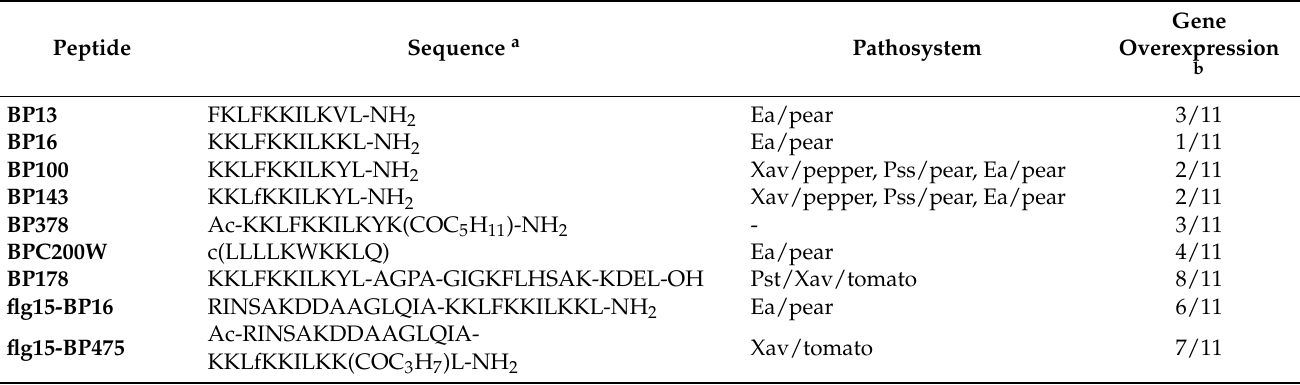
Table 2. Peptides assayed in planta for elicitation properties (overexpresed genes in tomato) and in detached plant material or plants for disease control in different pathosystems. Data extracted from several papers cited in the main